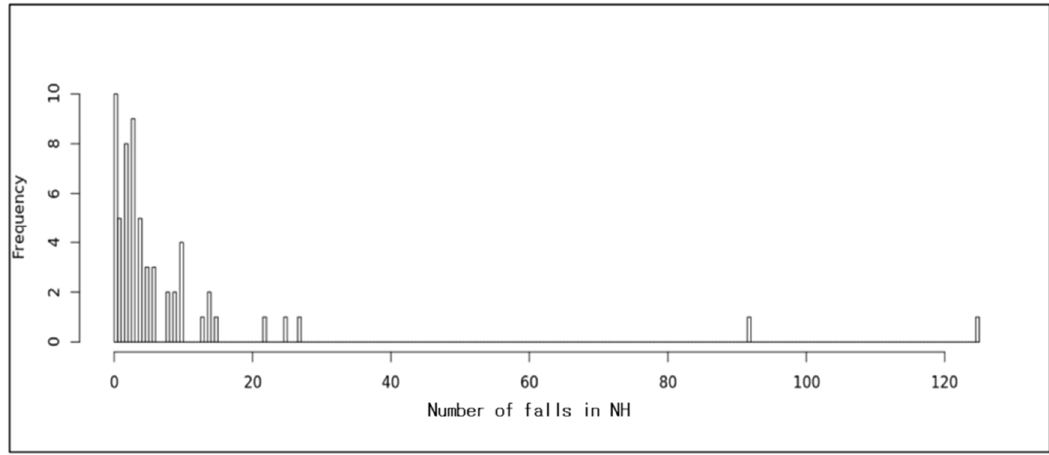
Figure 2. Histogram of falls. Table 2. Description of variables.